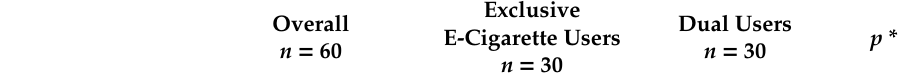
Table 1. Patterns and habits of e-cigarette use among e-cigarette users and dual